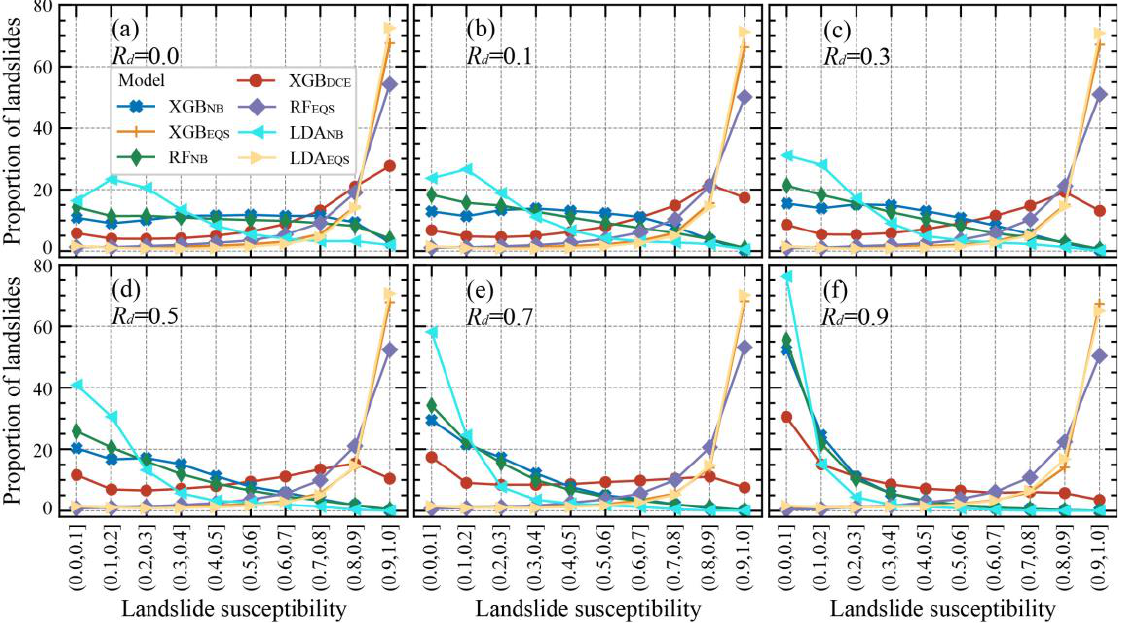
Figure 8. The relationship between the proportion of landslides and the landslide susceptibility. From subfigures ( a – f ), the R d increases, and the part of the landslide that the model seeks to predict is reduced from the entire landslide to the landslide scarp. Because some of the plots almost overlap (XGB-based model versus LGB-based model and EQS-based model versus ILW-based model), for greater clarity we only show representative model